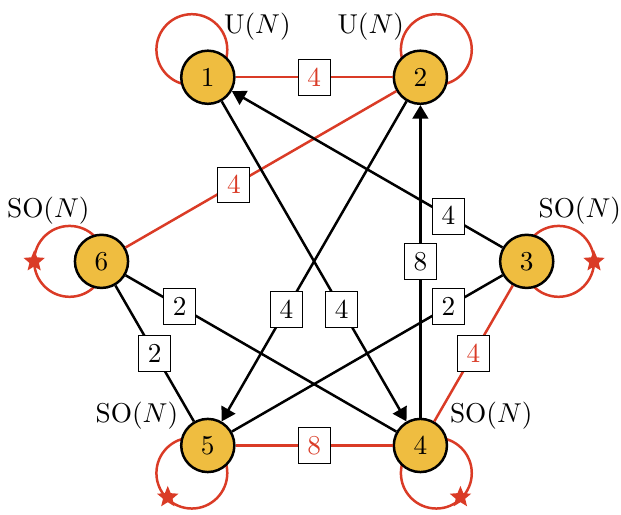
Figure 28 . Quiver diagram for the Spin(7) orientifold of phase H of Q 1 , 1 , 1 / Z 2 using the involution in eqs. (C.8), (C.9) and (C.10), together with our choice of γ